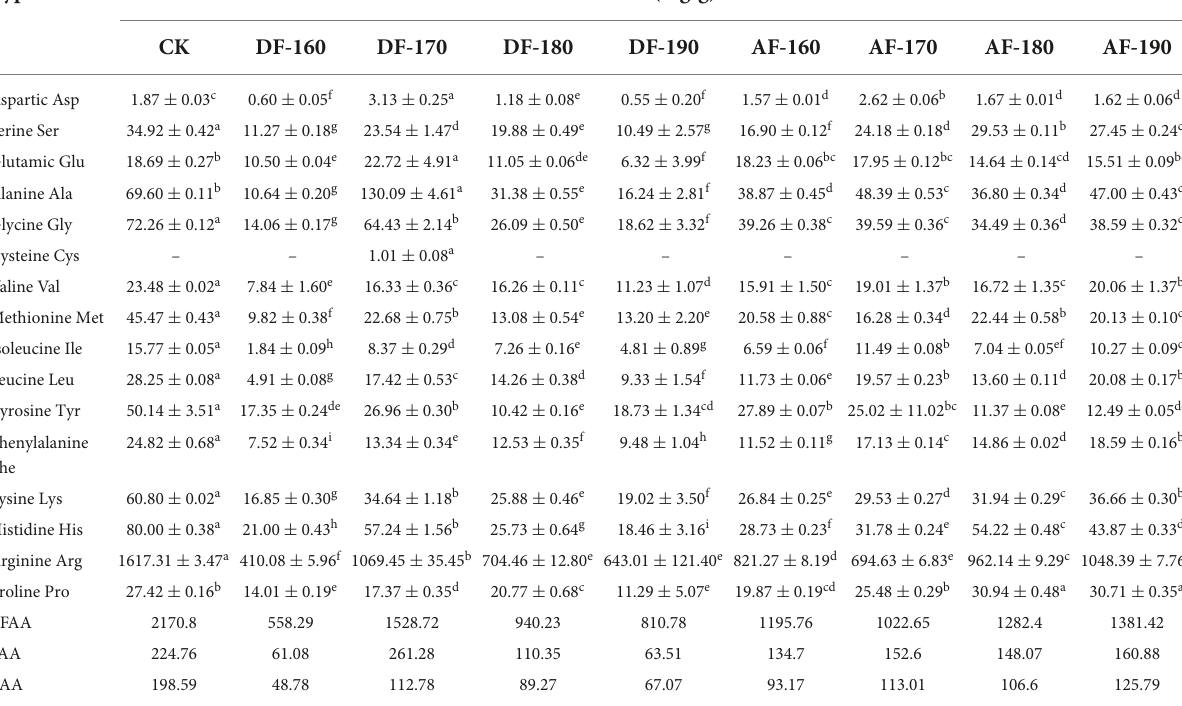
TABLE 5 Effect of frying method and temperature on the FAAs of shrimp meat.